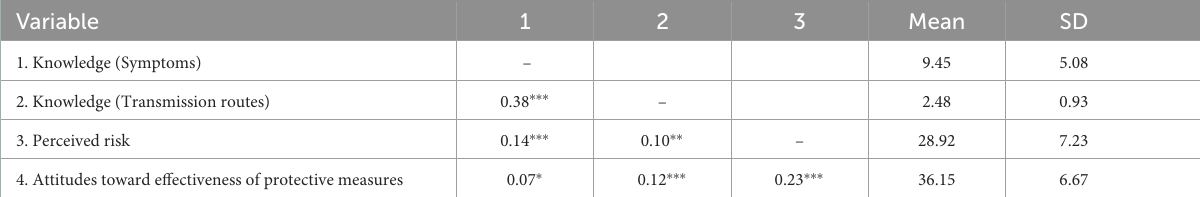
TABLE 8 Correlations and descriptive statistics for attitudes toward effectiveness of protective measures and predictor variables.